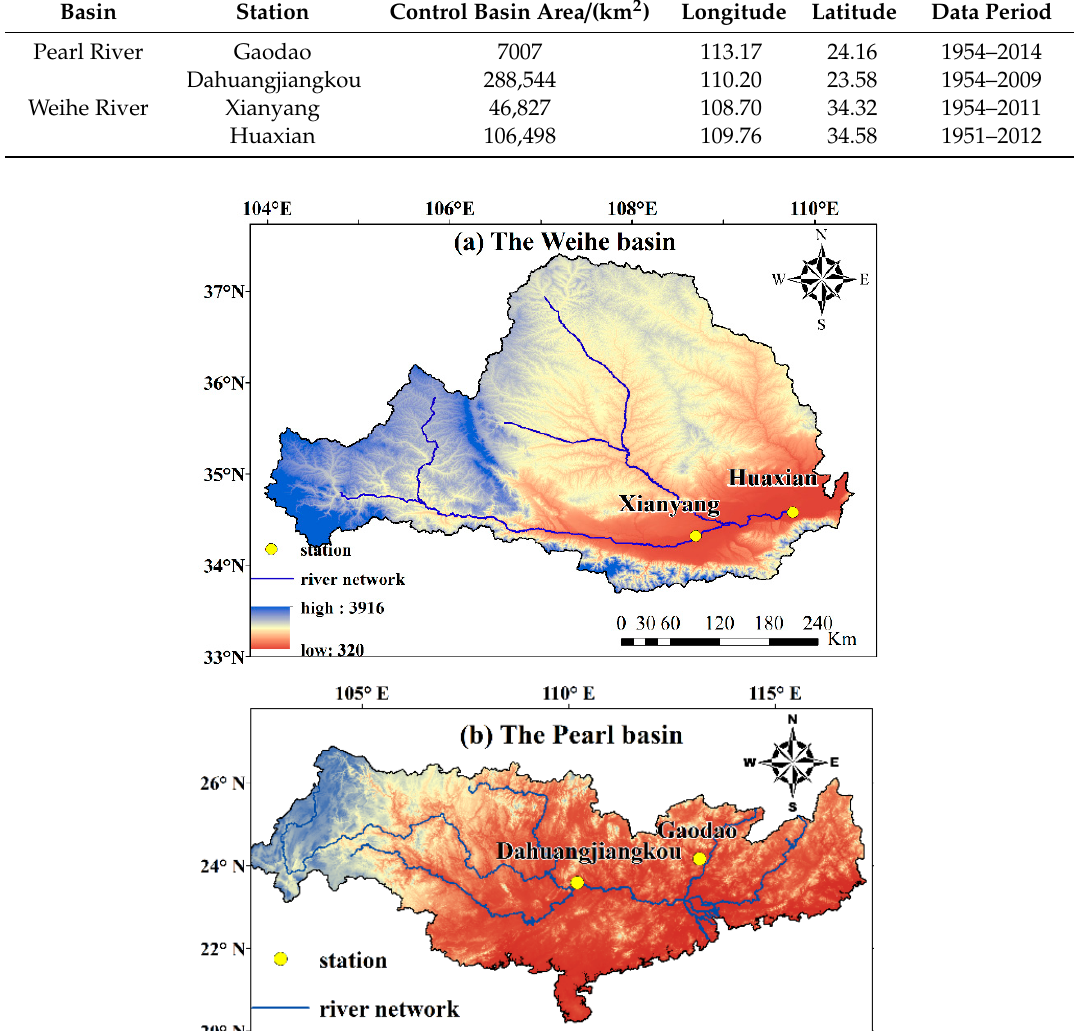
Table 2. Results of trend analysis for each station. Figure 2. Linear trend line of annual maximum flood series for ( a ) Huaxian station; ( b ) Gaodao station; ( c ) Dahuangjiangkou station; ( d ) Xianyang station.